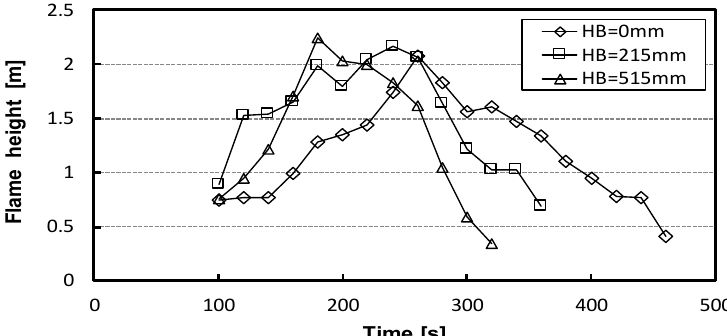
Figure 8. Experimental results of average flame height.